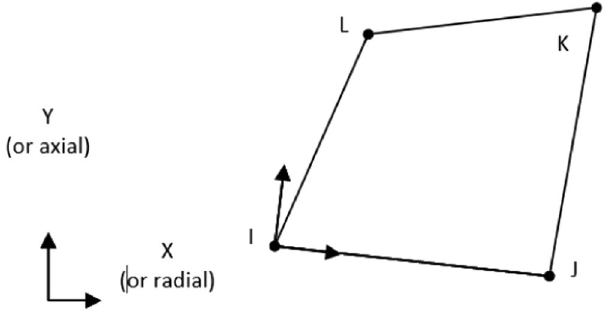
Figure 2. Geometry of PLANE13 Geometry of